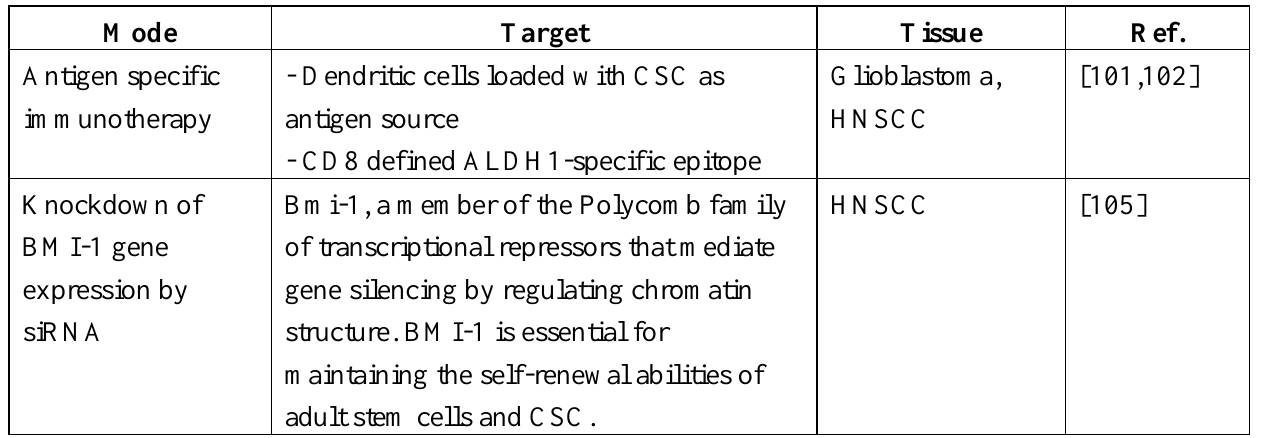
Table 2. Examples of targeted